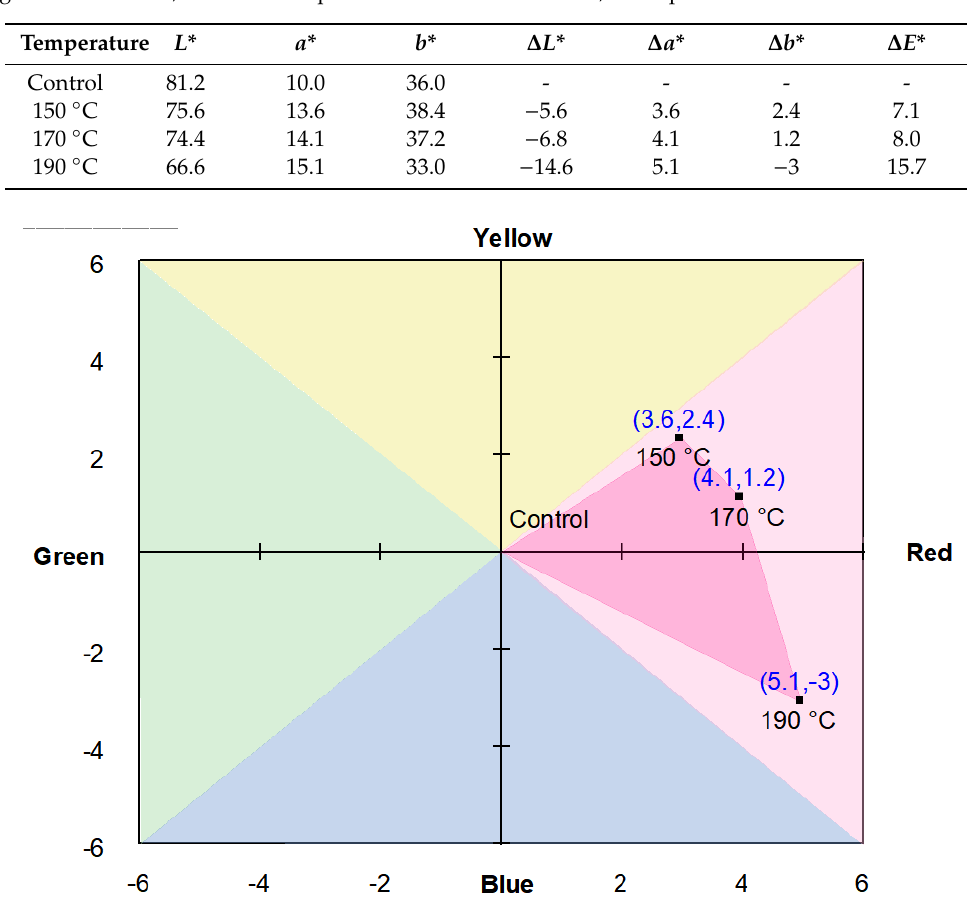
Figure 5. Colorimetric difference analysis of Masson pine wood as a function of temperature (The x-coordinate: ∆ a *; the y-coordinate: ∆ b *).